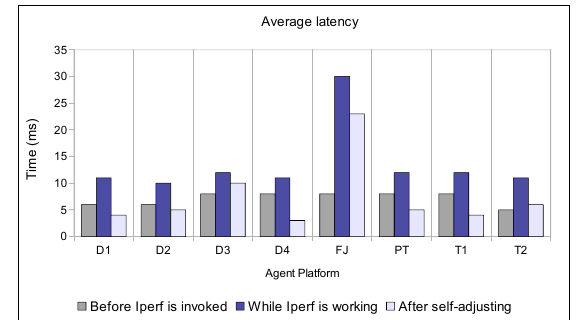
Figure 14. Avarage latencies of all platforms